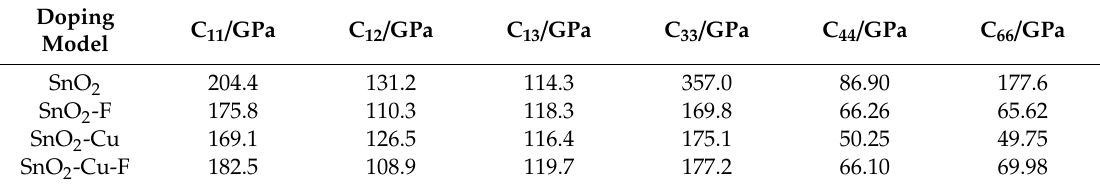
Table 2. The elastic coe ffi cients of intrinsic SnO 2 and di ff erent doping systems.